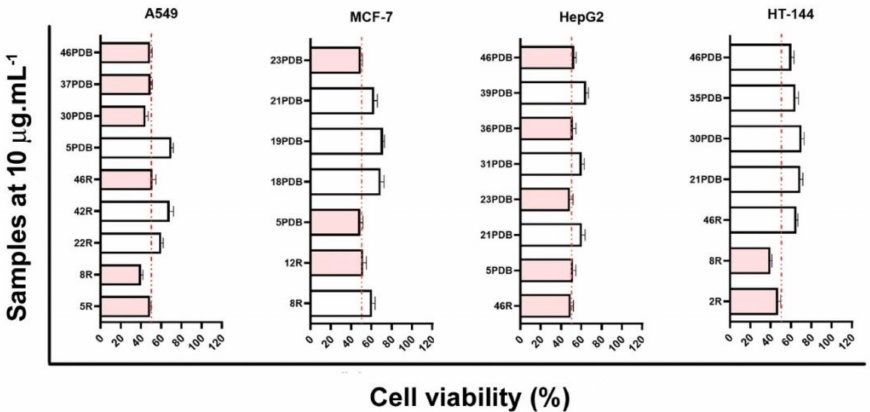
Figure 1. Cell viability of cultured human tumor cell lines with endophytic fungi extracts. Cells were treated for 48 h with crude extracts at 10 µ g mL − 1 . Codes next to bars refer to extracts of CarGL strains from R (rice incubation) and PDB (potato dextrose broth incubation). White bars refer to a medium cytotoxic activity, and pink bars refer to high cytotoxic